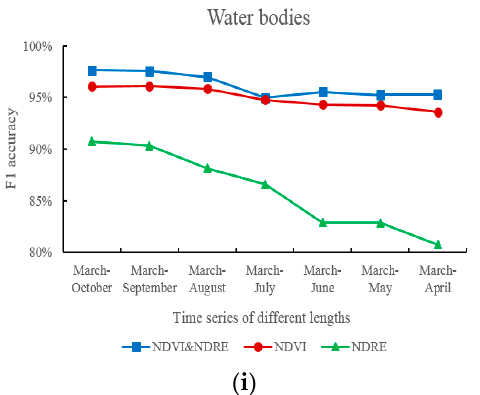
Figure 6. F1 accuracy of three different time series lengths of NDVI&NDRE, NDVI, and NDRE about different land cover and crops in 2019. ( a ) Winter wheat-summer maize, ( b ) Spring maize, ( c ) Cotton, ( d ) Minor crops, ( e ) Greenhouses, ( f ) Orchards, ( g ) Woods, ( h ) Cities and towns, and ( i ) Water bodies.